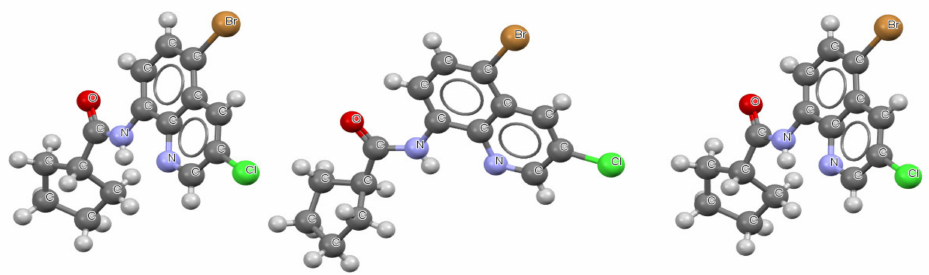
Figure 4. The fragment of the crystal structure of N–(5-bromo-3-chloroquinolin-8-yl) cyclopentanecar- boxamide (NARBEX refcode); small grey circles correspond to